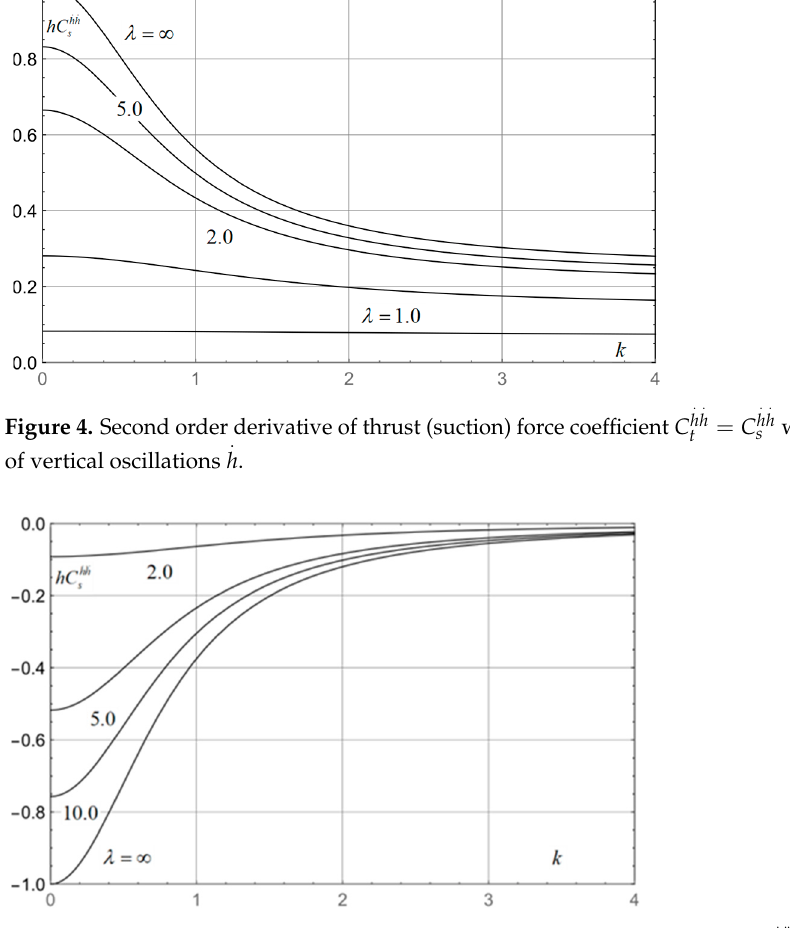
Figure 5. Mixed second order derivative of thrust (suction) force coefficient C hh to vertical speed h and acceleration h .